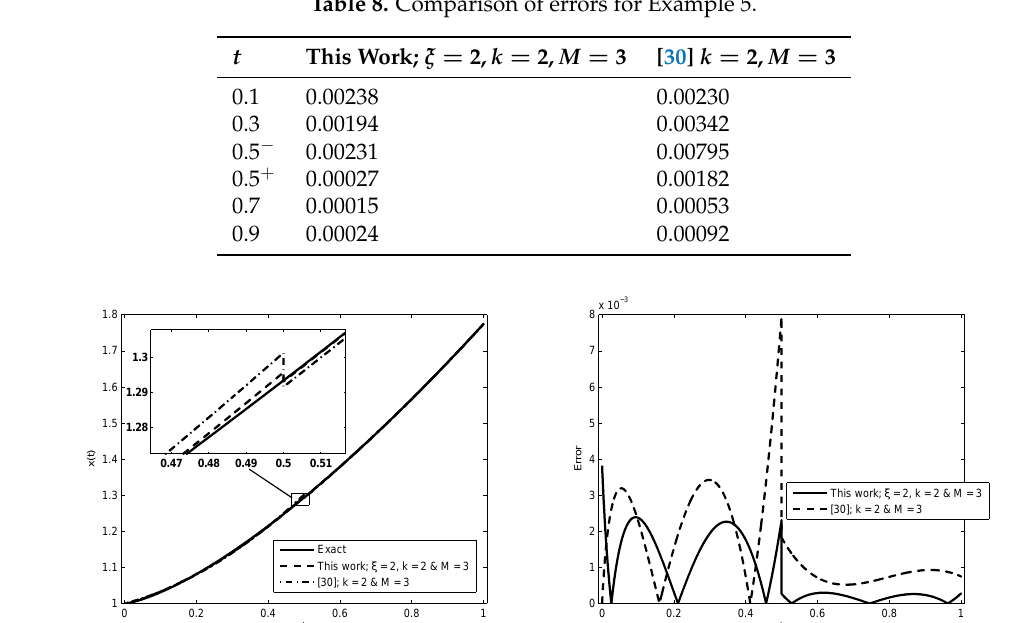
Table 8. Comparison of errors for Example 5.